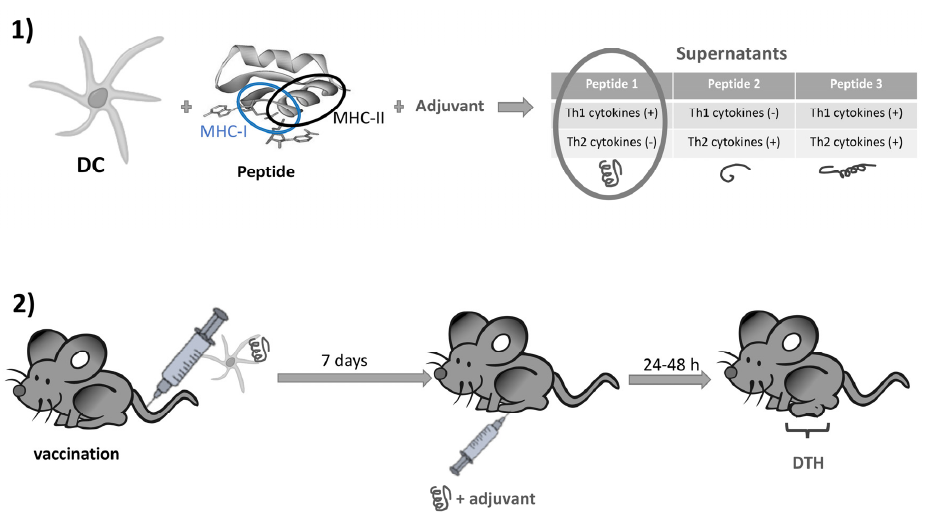
Figure 2. Methodology using dendritic cells (DCs) and adjuvants to select vaccine antigens for cell- mediated immunity. (1) DC loaded with peptides, good Major histocompatibility (MHC)-I and MHC-II binders and a Th1 adjuvant are checked for Th1 and Th2 cytokine releases. (2) Peptides inducing Th1 cytokines are selected and validated in mice vaccinated with DCs loaded with the peptides and inoculated into the footpads to measured delayed hypersensitivity (DTH) reactions. Peptides inducing strong DTH reactions are considered good candidates for future